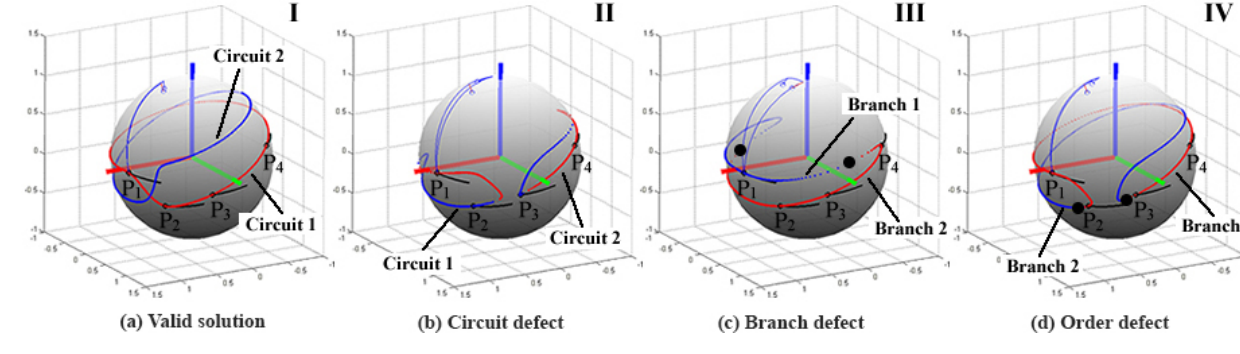
Figure 10. Solutions visualization.